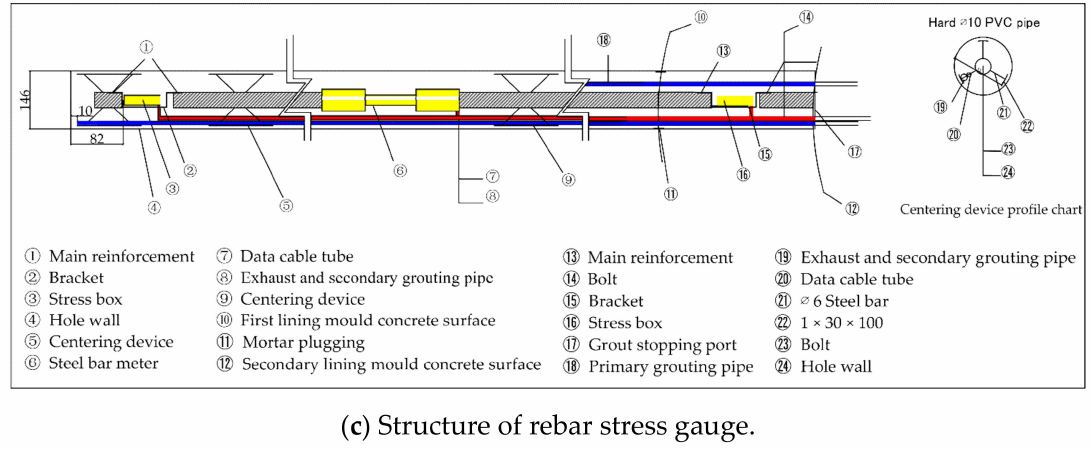
Figure 6. Layout of stress sensors and rebar stress gauge in tunnel.